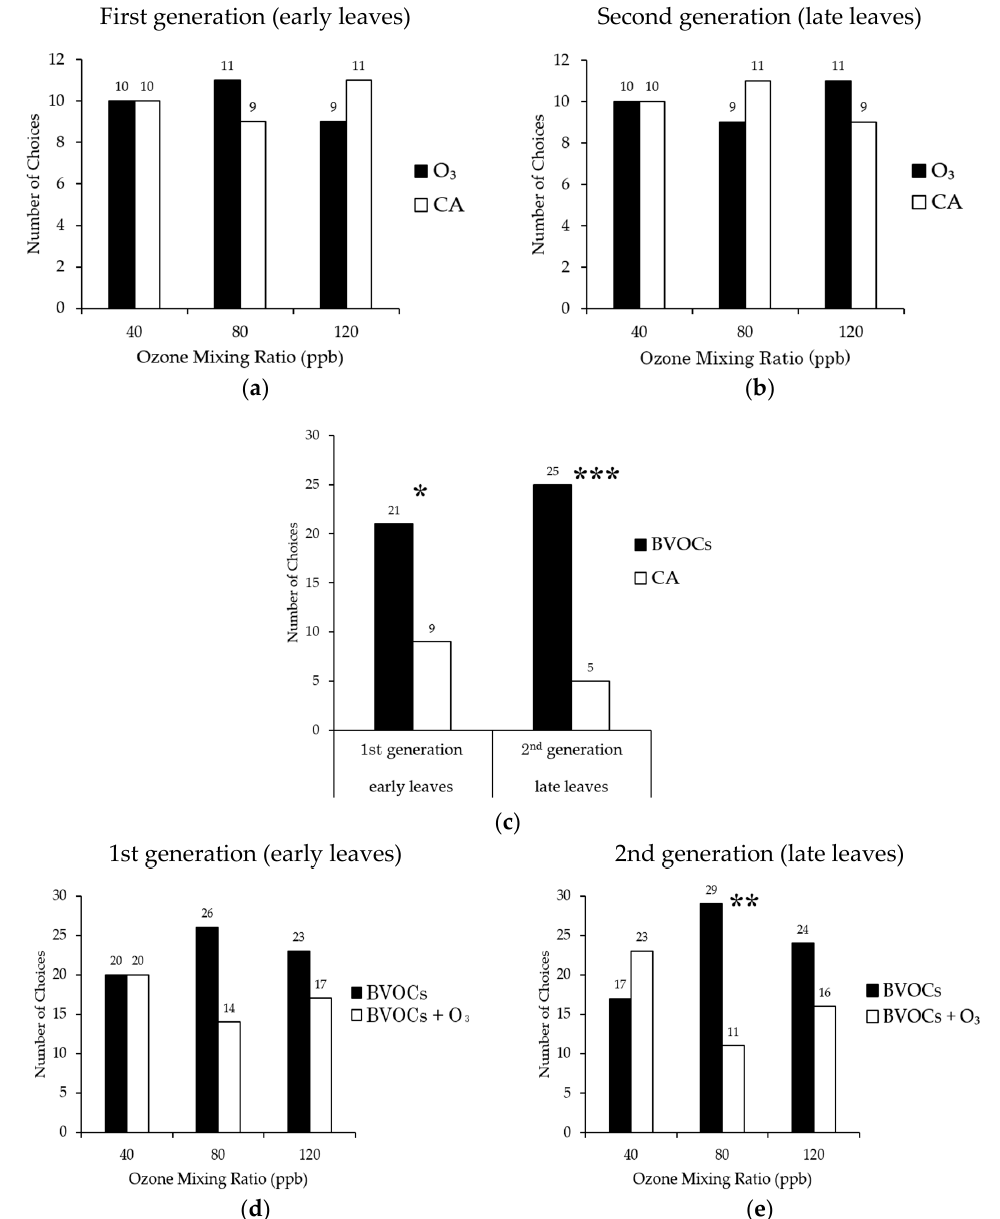
Figure 3. Y-tube preference test {1} O 3 vs. cleaned air (CA) ( a ) with first generation of adult leaf beetles and with second generation ( b ), test (2) biogenic volatile organic compounds (BVOCs; from leaves of white birch) vs. CA ( c ), and test (3) BVOCs vs. BVOCs + O 3 with first generation ( d ) and second generation ( e ). The values on bars are total number of choices to each side of Y-tube in each test. Astericks stand for p > 0.05 *; p > 0.01 **; and p > 0.001 *** in the binominal test. In test (3) (Figure 3d,e), BVOCs versus BVOCs mixed with O 3 (BVOC + O 3 ), the leaf beetles of both first and second generation larvae had no preference between BVOCs and BVOCs + O 3 at 40 ppb in June and August (BVOCs emitted from early and late leaves, respectively). At 80 ppb, although not statistically significant, first generation as well as second generation in August ( p < 0.01) tended to prefer BVOCs over BVOCs + O 3 ( p = 0.08). The attractiveness of BVOCs from leaves was apparently degraded by higher O 3 exposure from the results at 40 and 80 ppb O 3 . However, at 120 ppb, although insects more frequently preferred BVOCs by comparison with that at 40 ppb O 3 , the differences were not statistically significant in both seasons.